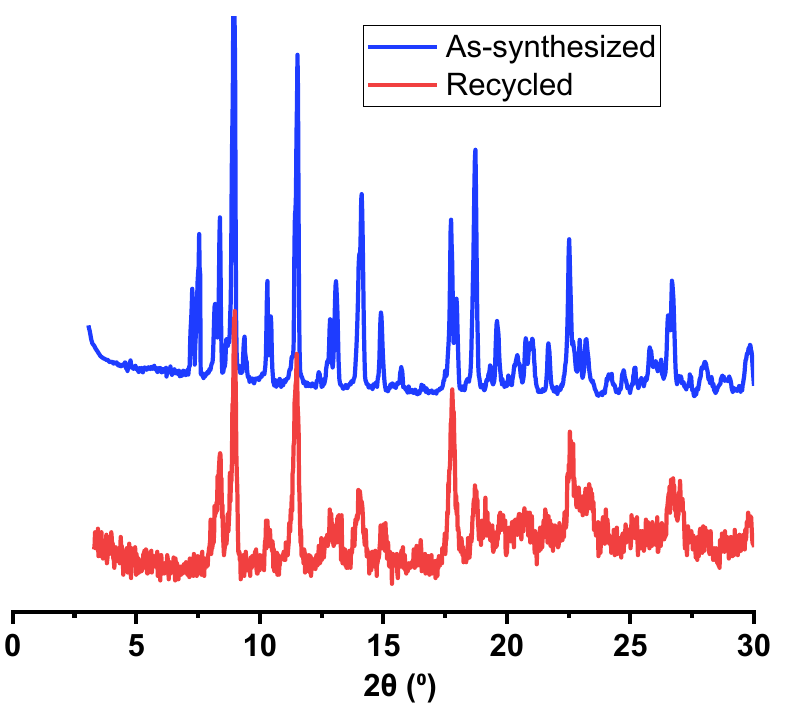
Figure 14. PXRD of the as − synthesized and recycled CdMOF after three catalytic cycles.